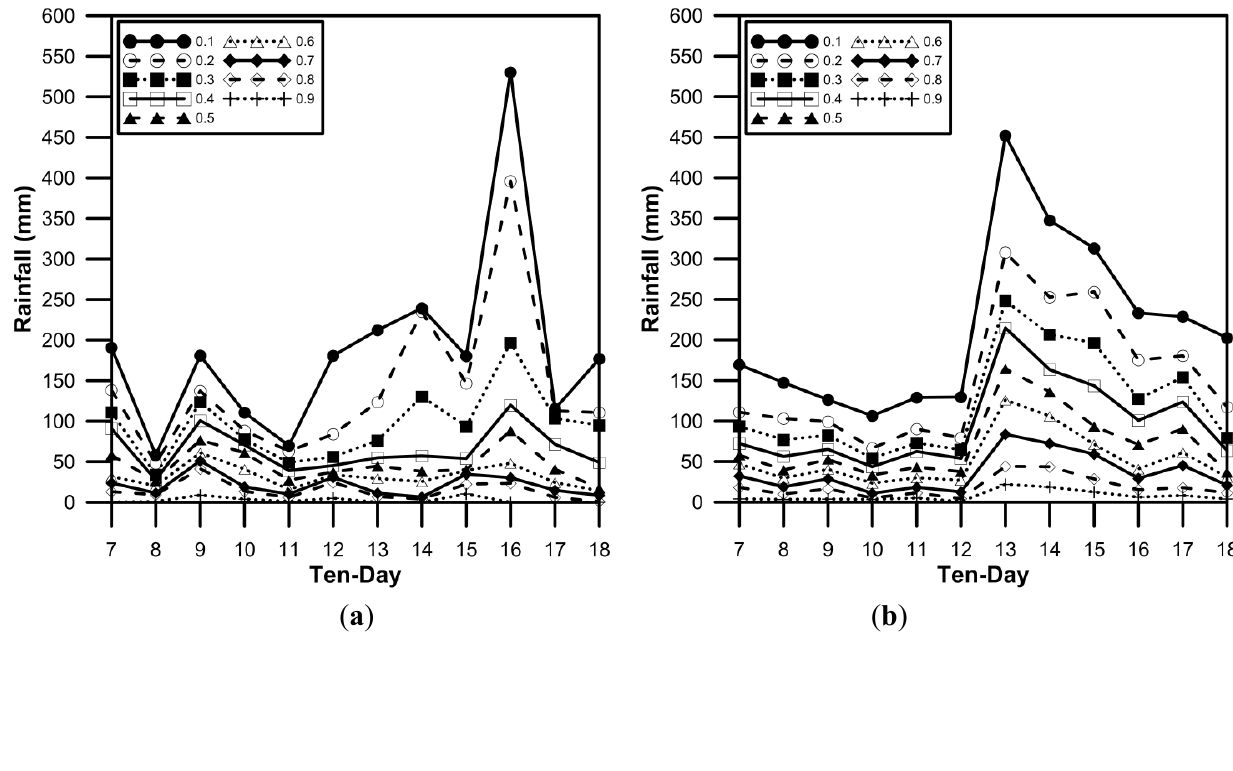
Figure 13. Exceedance probability distribution of rainfall at each ten-day during the first cropping season. ( a ) present (2004–2011); ( b ) future